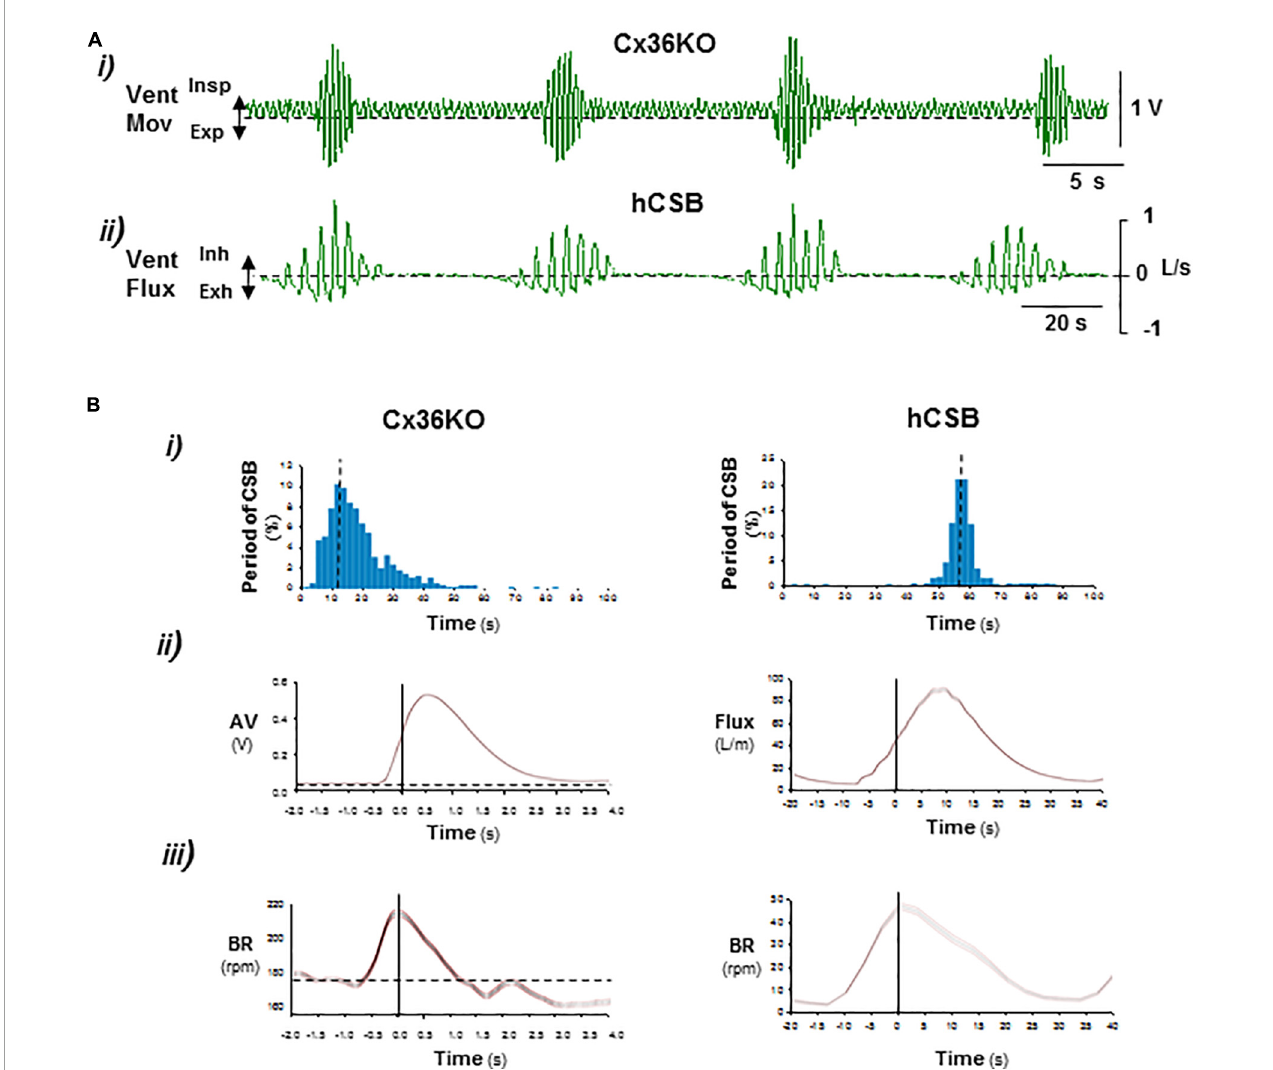
FIGURE1 Comparison of periodic respiration of postnatal connexin-36 knockout mouse with human Cheyne–Stokes breathing. (A) Representative records of ventilatory movement in P14 Cx36KO mouse ( Vent Mov) and ventilatory flux ( Vent Flux ) in human Cheyne–Stokes breathing, hCSB (i,ii). (B) Respiratory parameters of breathing patterns shown in (A) ( N = 30 CSB cycles for Cx36KO and hCSB). (i) Interval histogram of oscillatory period, (ii) average of ventilatory motion amplitude in Cx36KO ( AV ) and flux in hCBS, and (iii) breathing rate ( BR ). Periodic breathing of the Cx36KO mouse shares all pathognomonic features of hCSB but on a faster time